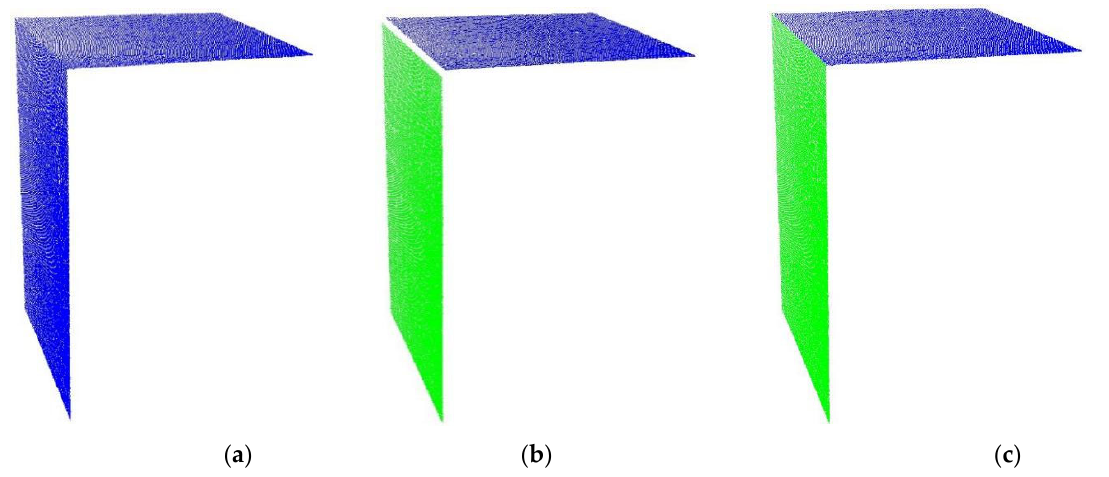
Figure 8. ( a ) Raw data; ( b ) The region growing algorithm; ( c ) The proposed method.